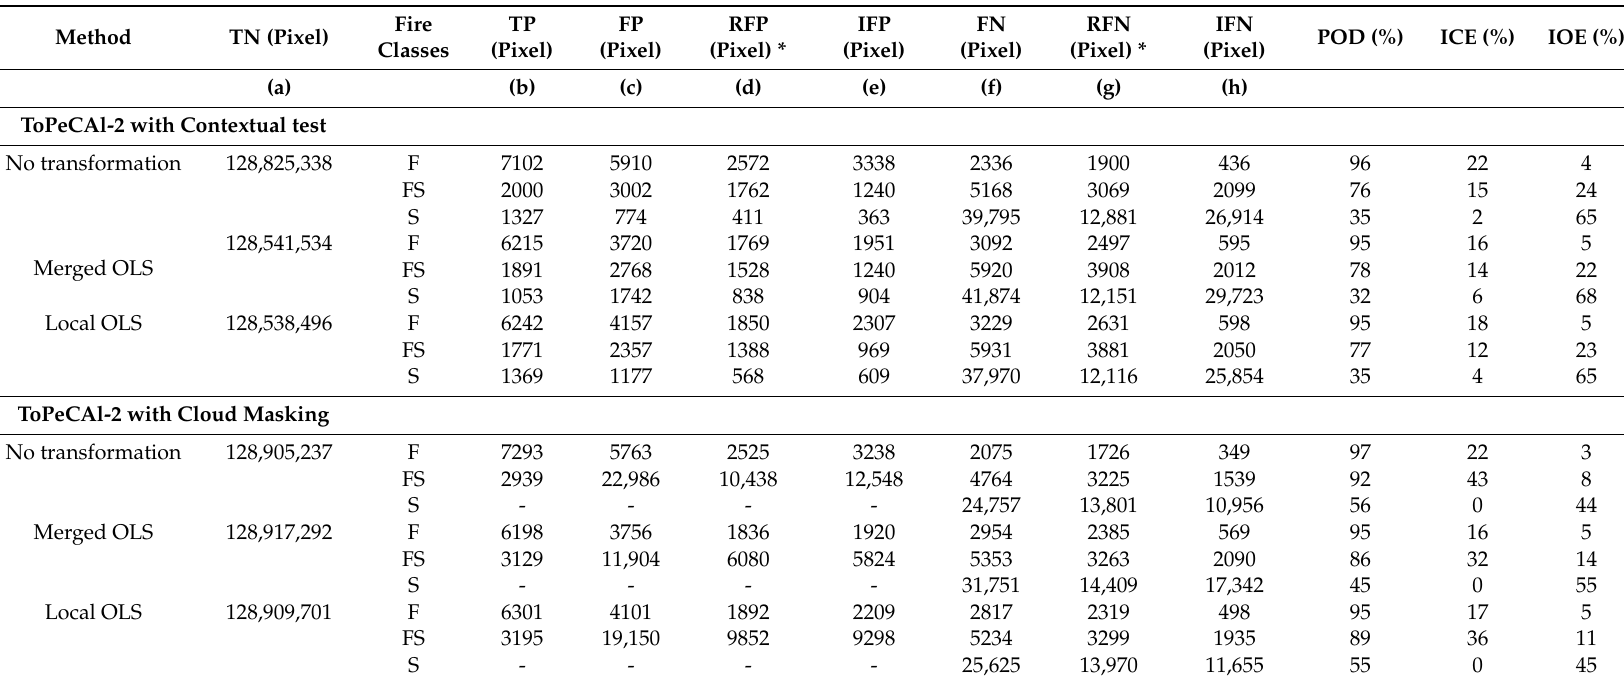
Table A5. As per Table A4 but showing the comparison of fire classes, i.e., flaming (F), smouldering (S), and mix of flaming and smouldering (FS). Method